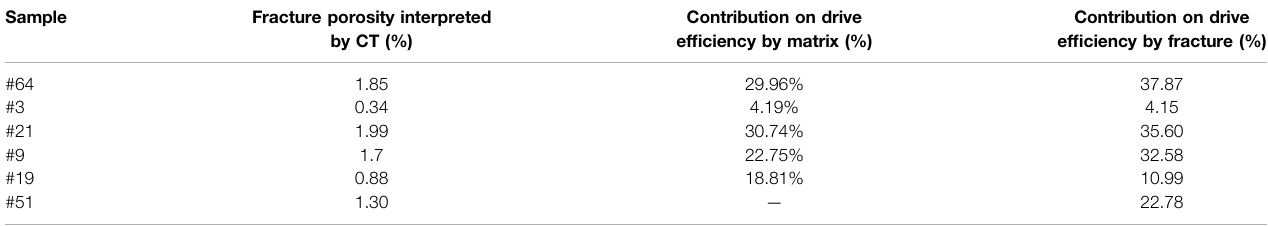
TABLE 8 | Contributions on drive ef fi ciency by the fracture or matrix. Sample